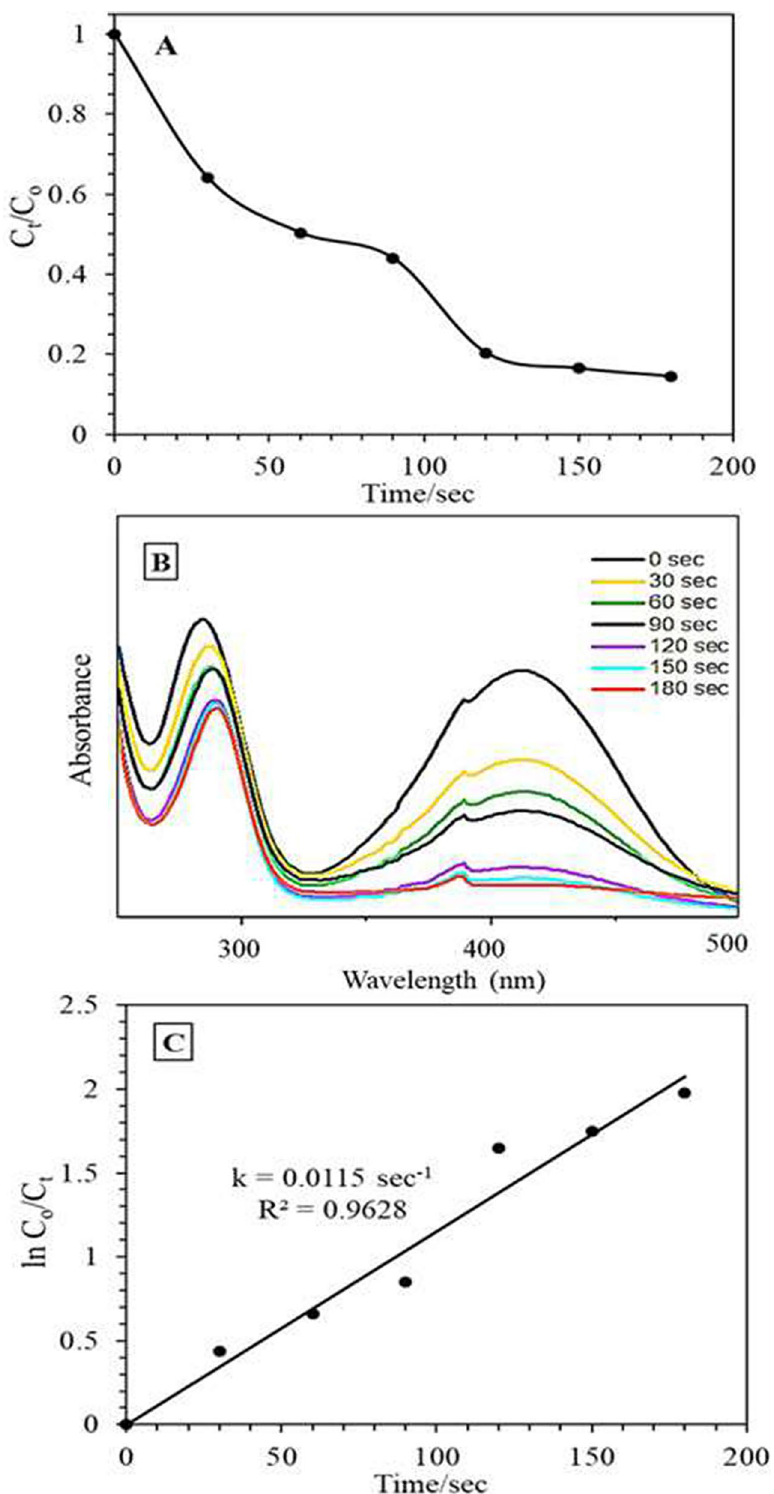
Figure 9. ( A ) The change in the concentration of 4-nitroanilin with time on the Mn 3 O 4 /α-Ag 2 WO 4 (60%) photocatalyst, ( B ) the change in the concentration of 4-nitroanilin with time, ( C ) Plots of Ln (C t /C 0 ) vs. time for the reduction of 4-nitroanilin (Reaction conditions: 3 mL 4-nitroanilin of conc. 0.001 M, NaBH 4 conc. of 0.2 M, 3 mg catalyst (1 g/L), T = 289 K, Led lamp 50